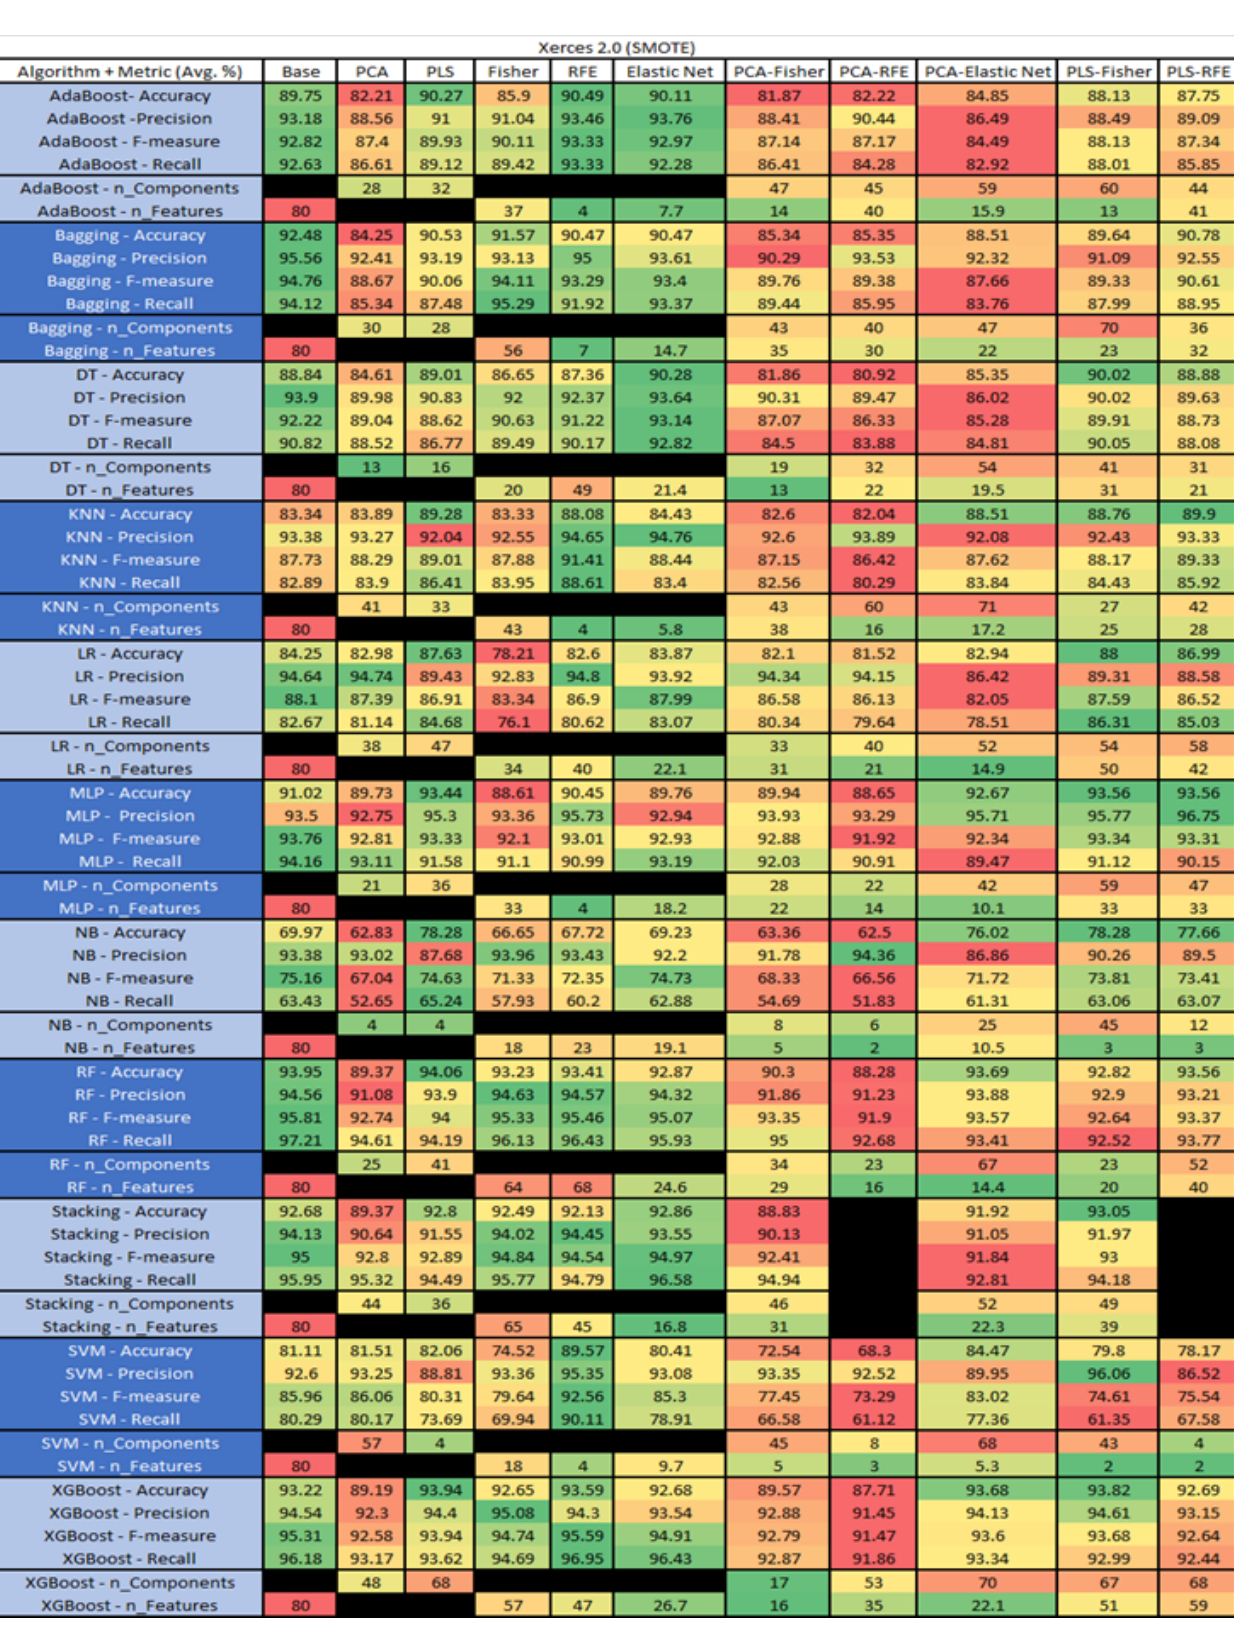
Figure 59. Xerces 2.0 SMOTE PROMISE Results Data